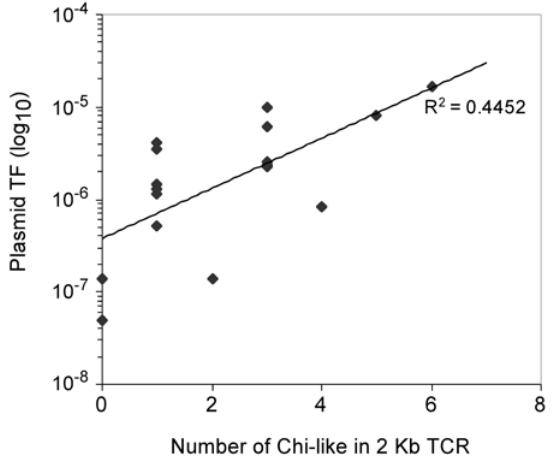
Figure 6. Correlation between plasmid recombination frequencies and the number of Chi-like motifs within the 2 kb long DNA fragment. TF, transformation frequency.